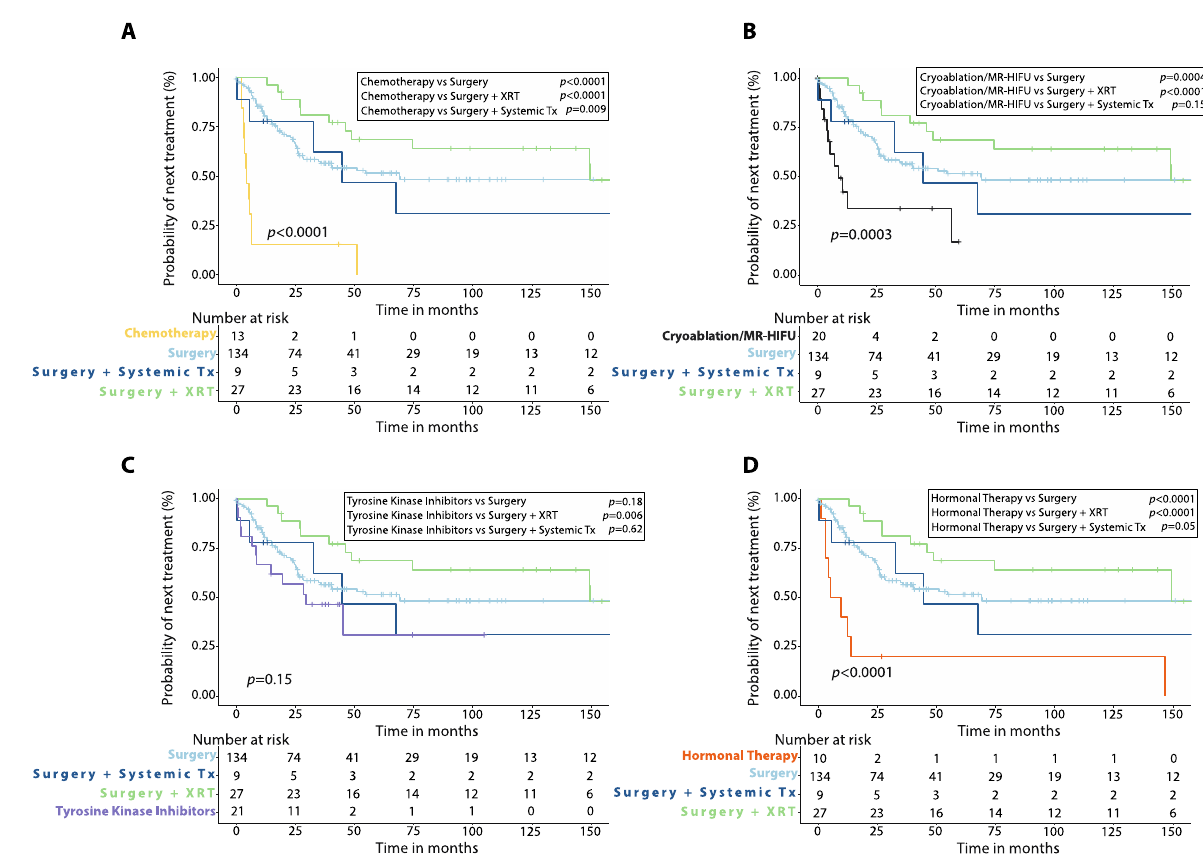
Figure 3. Time to next treatment (TTNT) after first ‐ line therapy in patients with desmoid tumors. Kaplan–Meier curves show comparison of TTNT between patients treated with first ‐ line chemo ‐ therapy ( A ), cryoablation or MR ‐ HIFU ( B ), tyrosine kinase inhibitors ( C ), or hormonal therapy ( D ) versus surgery alone, surgery plus adjuvant radiotherapy (XRT) or surgery plus adjuvant systemic therapy. P ‐ values were calculated with the Log ‐ Rank method. XRT: radiotherapy; Systemic Tx: Sys ‐ temic therapy; MR ‐ HIFU: Magnetic resonance ‐ guided high intensity focused ultrasound; Surgery plus systemic therapy includes surgery plus adjuvant chemotherapy, surgery plus adjuvant hormo ‐ nal therapy, surgery plus imatinib.